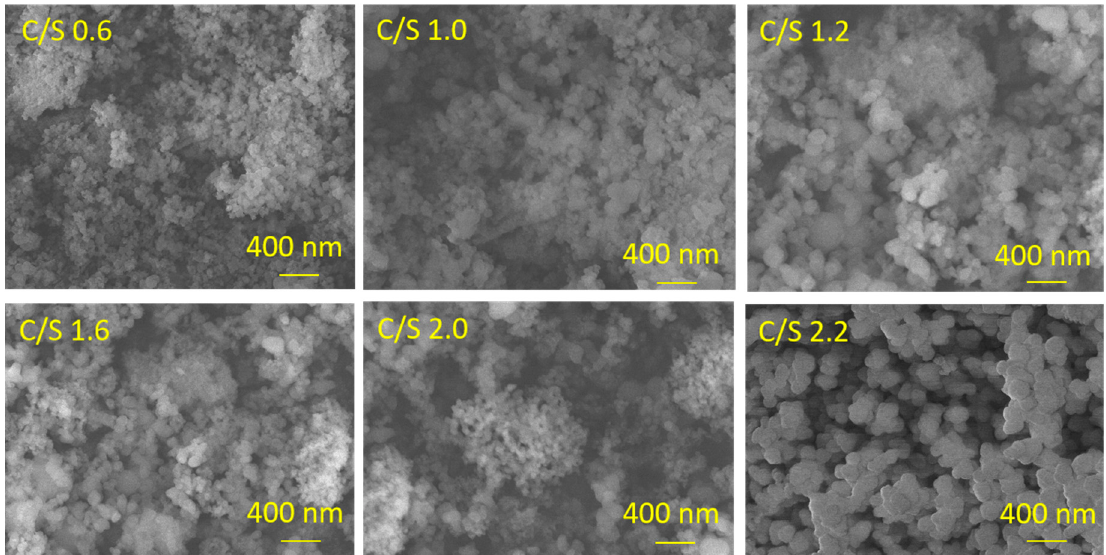
Figure 2. Surface morphology of CSH with different calcium silicon ratio.